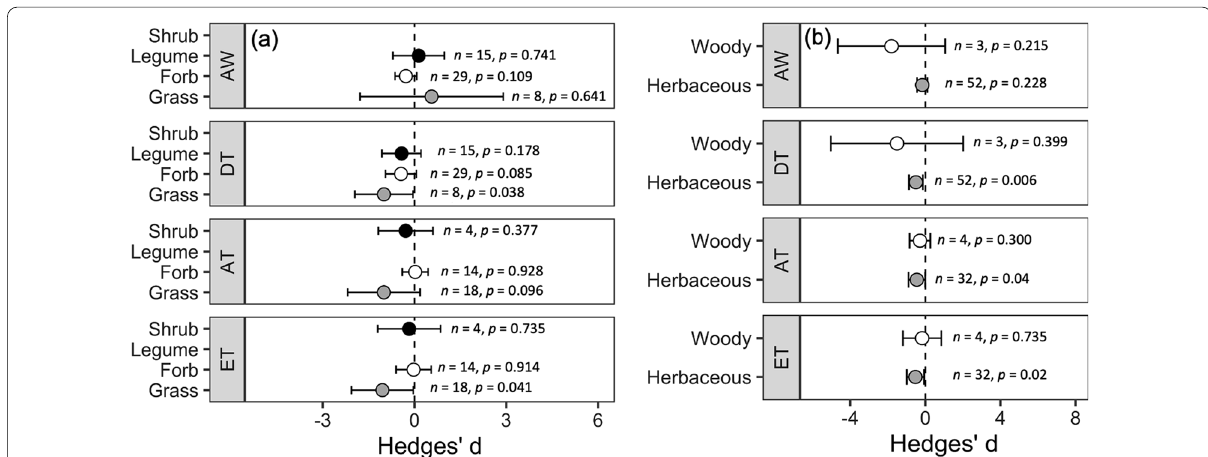
Fig. 3 Effects of temperature and rainfall on PSFs across plant functional groups ( a , b ). Mean PSFs effect size is presented with 95% CIs. Mean PSFs effect size is significantly different from zero if the corresponding CIs do not overlap with zero (dashed line). n represents the total number of observations used during analysis and p indicated whether mean PSFs effect sizes were significantly different from zero. Hedges’ d : 0 for no effect, 0.2 for small ( 20%), 0.5 for medium ( 50%), 0.8 for large ( 80%) and > 1.0 (> 100%) for strong large negative effects, respectively. AW: − − − − − − − ambient water; DT: drought; AT, ambient temperature; ET: elevated